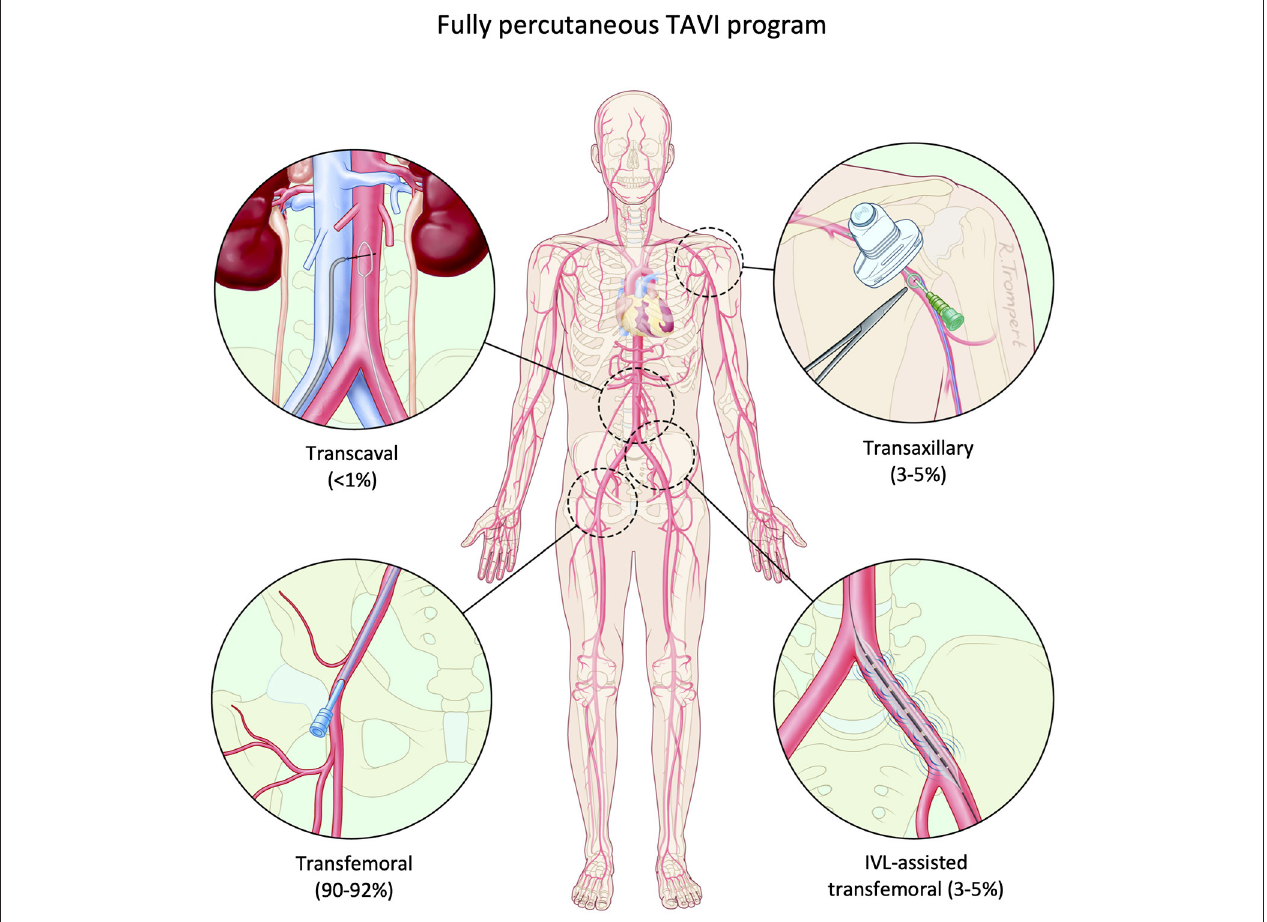
FIGURE 1 | Fully percutaneous TAVI program. A fully percutaneous TAVI program is safe and feasible using different access routes: routine transfemoral, IVL-assisted transfemoral, percutaneous transaxillary and transcaval approaches. IVL, intravascular lithotripsy; TAVI, transcatheter aortic valve